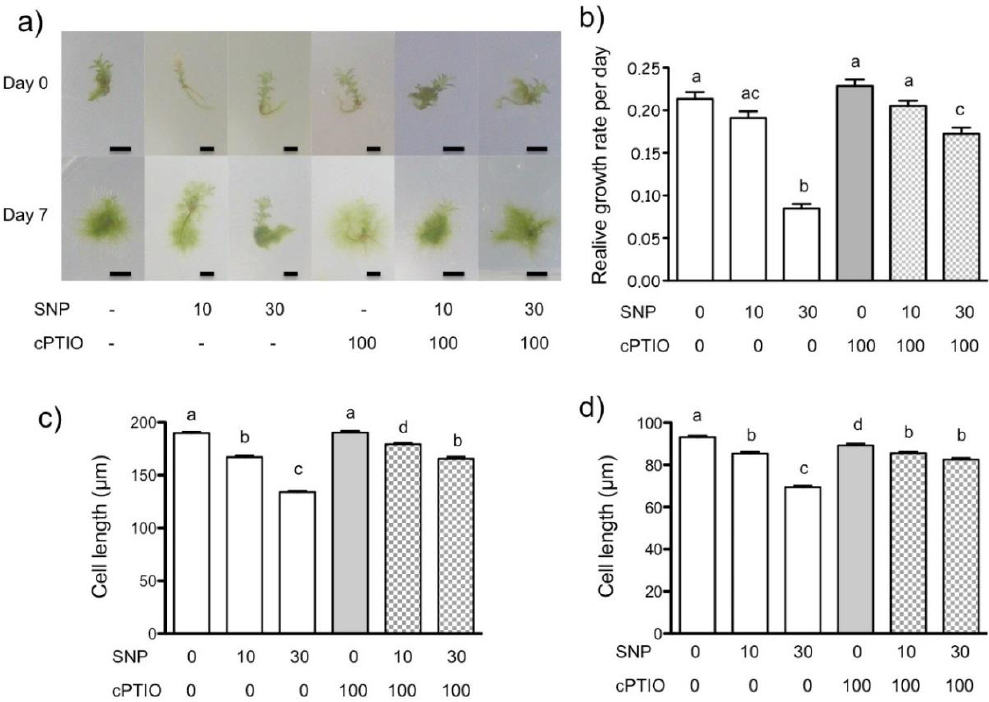
Figure 1. E ff ect of nitric oxide (NO) donors in P. patens growth. NO donor-dependent growth inhibition is reversed by a specific NO scavenger. ( a ) Comparison of plant area at the beginning (day 0) and the end (day 7) of treatment with the NO donor sodium nitroprusside (SNP) and / or NO scavenger 2-(4-carboxyphenyl)-4,4,5,5-tetramethylimidazoline-1-oxyde-oxyl-3-oxyde (cPTIO) at di ff erent concentrations in µ M. ( b ) Comparison of the relative growth rate of P. patens protonema under NO donor and scavenger treatments. Final cell lengths of caulonema ( c ) and chloronema ( d ) cells. One representative experiment is shown in ( a ); scale bar = 3 mm. Data shown in ( b ) are from four independent experiments ( n = 78), data shown in ( c , d ) are from four independent experiments ( n = 286) and were analyzed by one-way ANOVA and Tukey’s multiple comparison test. Di ff erent letters indicate statistical di ff erences among treatments at p < 0.05 .